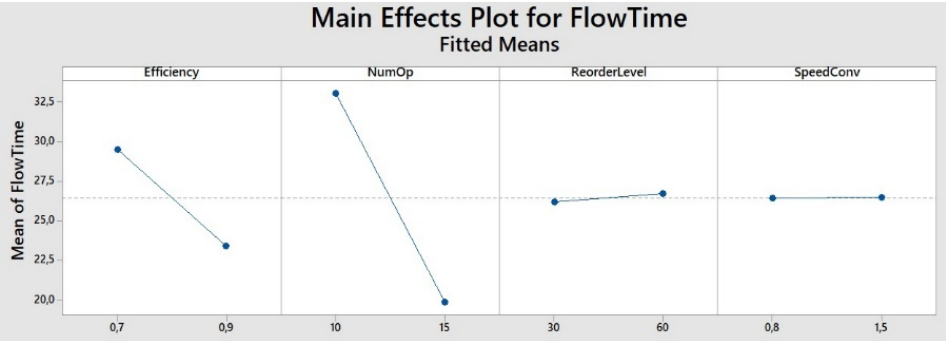
Figure 17. Main Effects Plot for Flow Time.